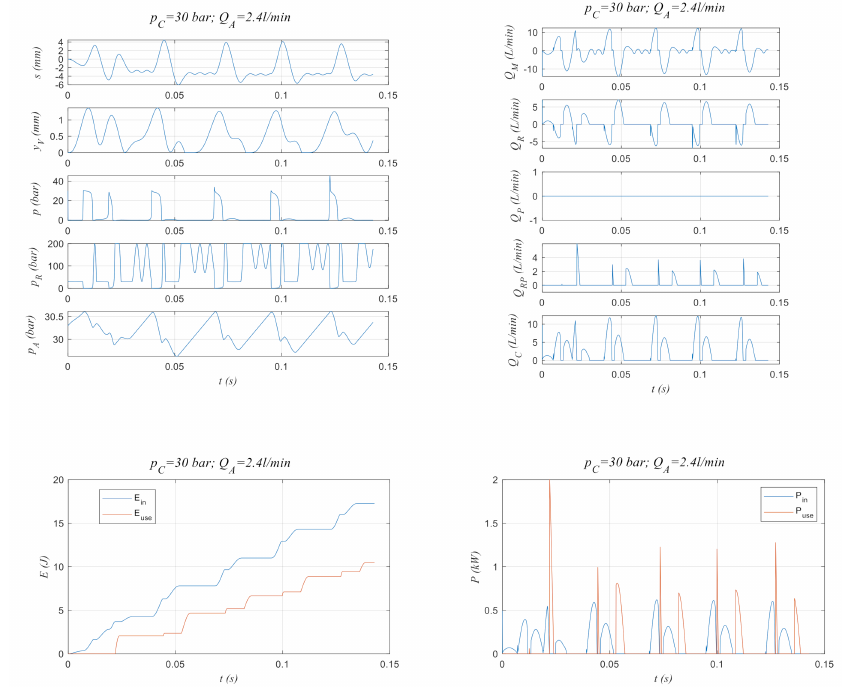
Figure 7. Results plots for p C = 30 bar, Q A = 2.4 L/min; s: piston position; y V : position valve spool; p, p R , p A : pressures in cylinder chambers and in entry side capacitance; Q M , Q R , Q P , Q RP , Q C : flow rates over switching valve to piston and rod side chambers, over check valves to system pressure, and to actuator CA; E in , E use , P in , P use : input and recuperated energy and power, respectively.